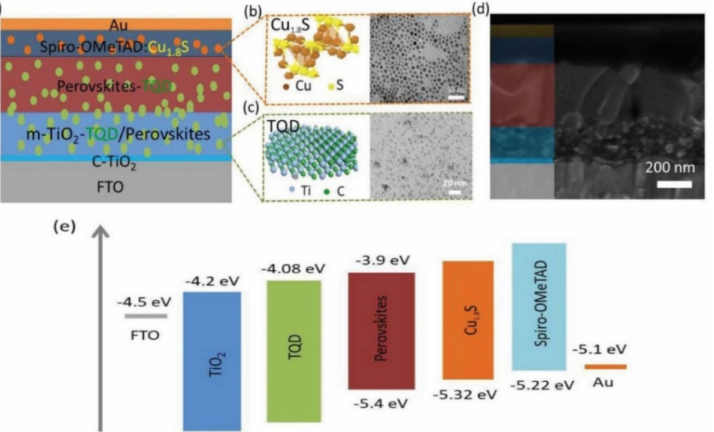
Figure 4. ( a ) PSC architecture. ( b ) Schematic structure and TEM image of Cu 1.8 S. ( c ) Schematic structure and TEM image ofTi 3 C 2 QDs. ( d ) Cross-sectional SEM of a complete device. ( e ) Energy diagram of each layer in PSCs. Reprinted with permission from Ref. [71]. Copyright 2020 WILEY- VCH Verlag GmbH & Co. KGaA,